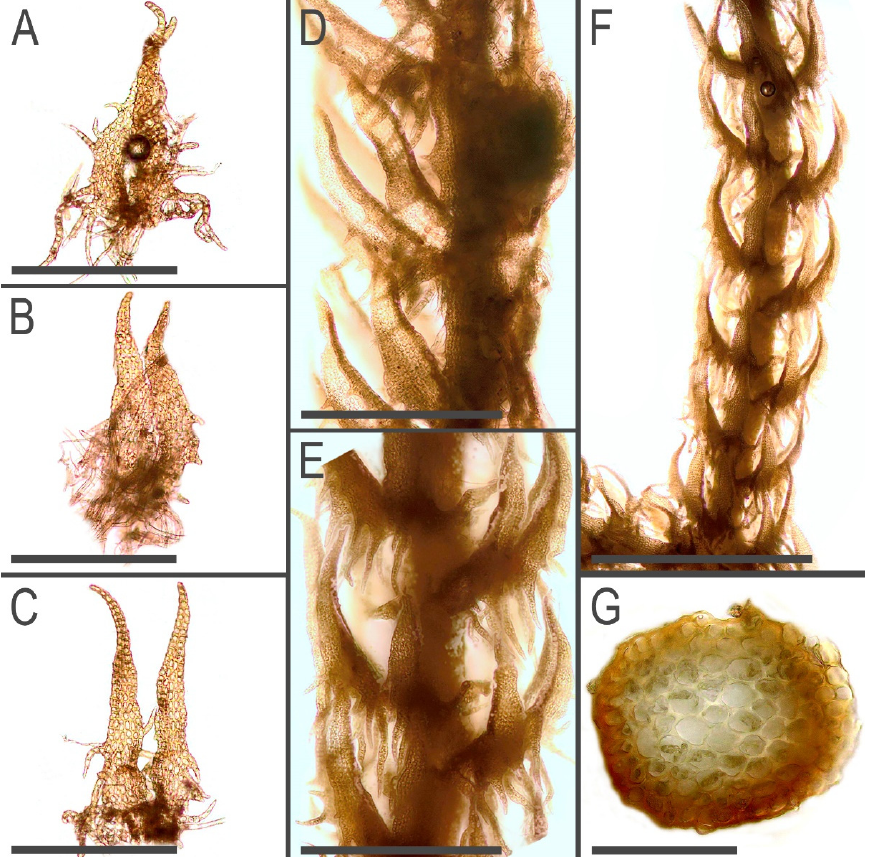
Figure 7. Tetralophozia filiformis (Steph.) Urmi: A – C —underleaves; D —plant habit. fragment. lateral view; E , F —plant habit. fragment dorsal view; G —stem cross section. Scales: A – C —300 µ m; D , E — 500 µm; F —1 mm; G —100 µm. All from C-39-1-17 (VBGI).